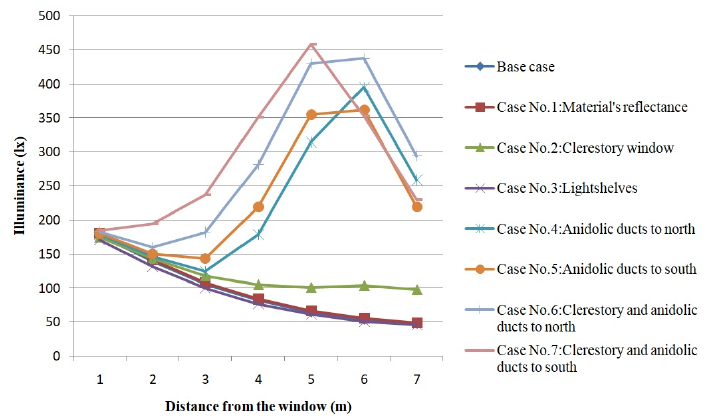
Figure 19. Comparison of average illuminance levels on the desks plane on 21 st of June at 12:00 pm.